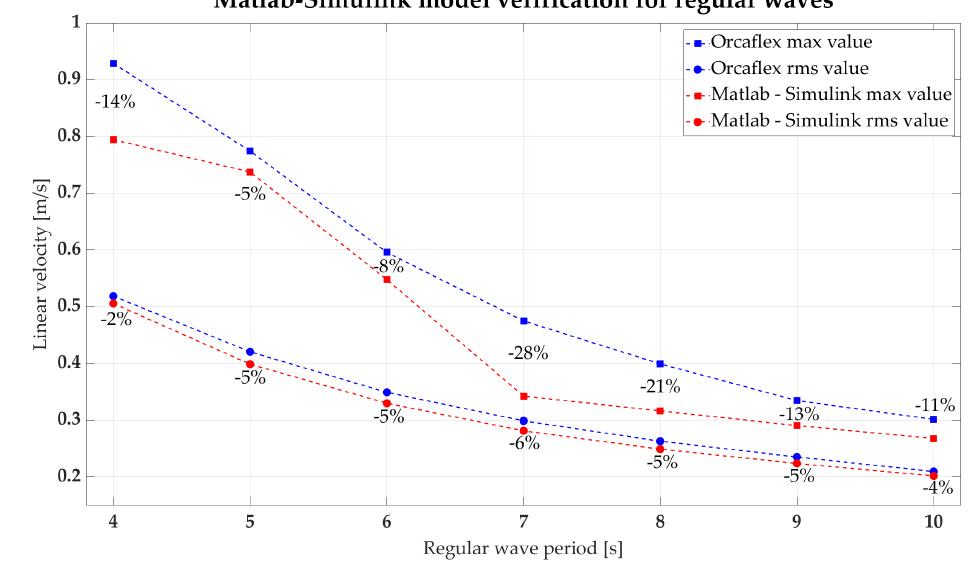
Figure 5. Regular wave comparison between Orcaflex and the Matlab-Simulink tool.